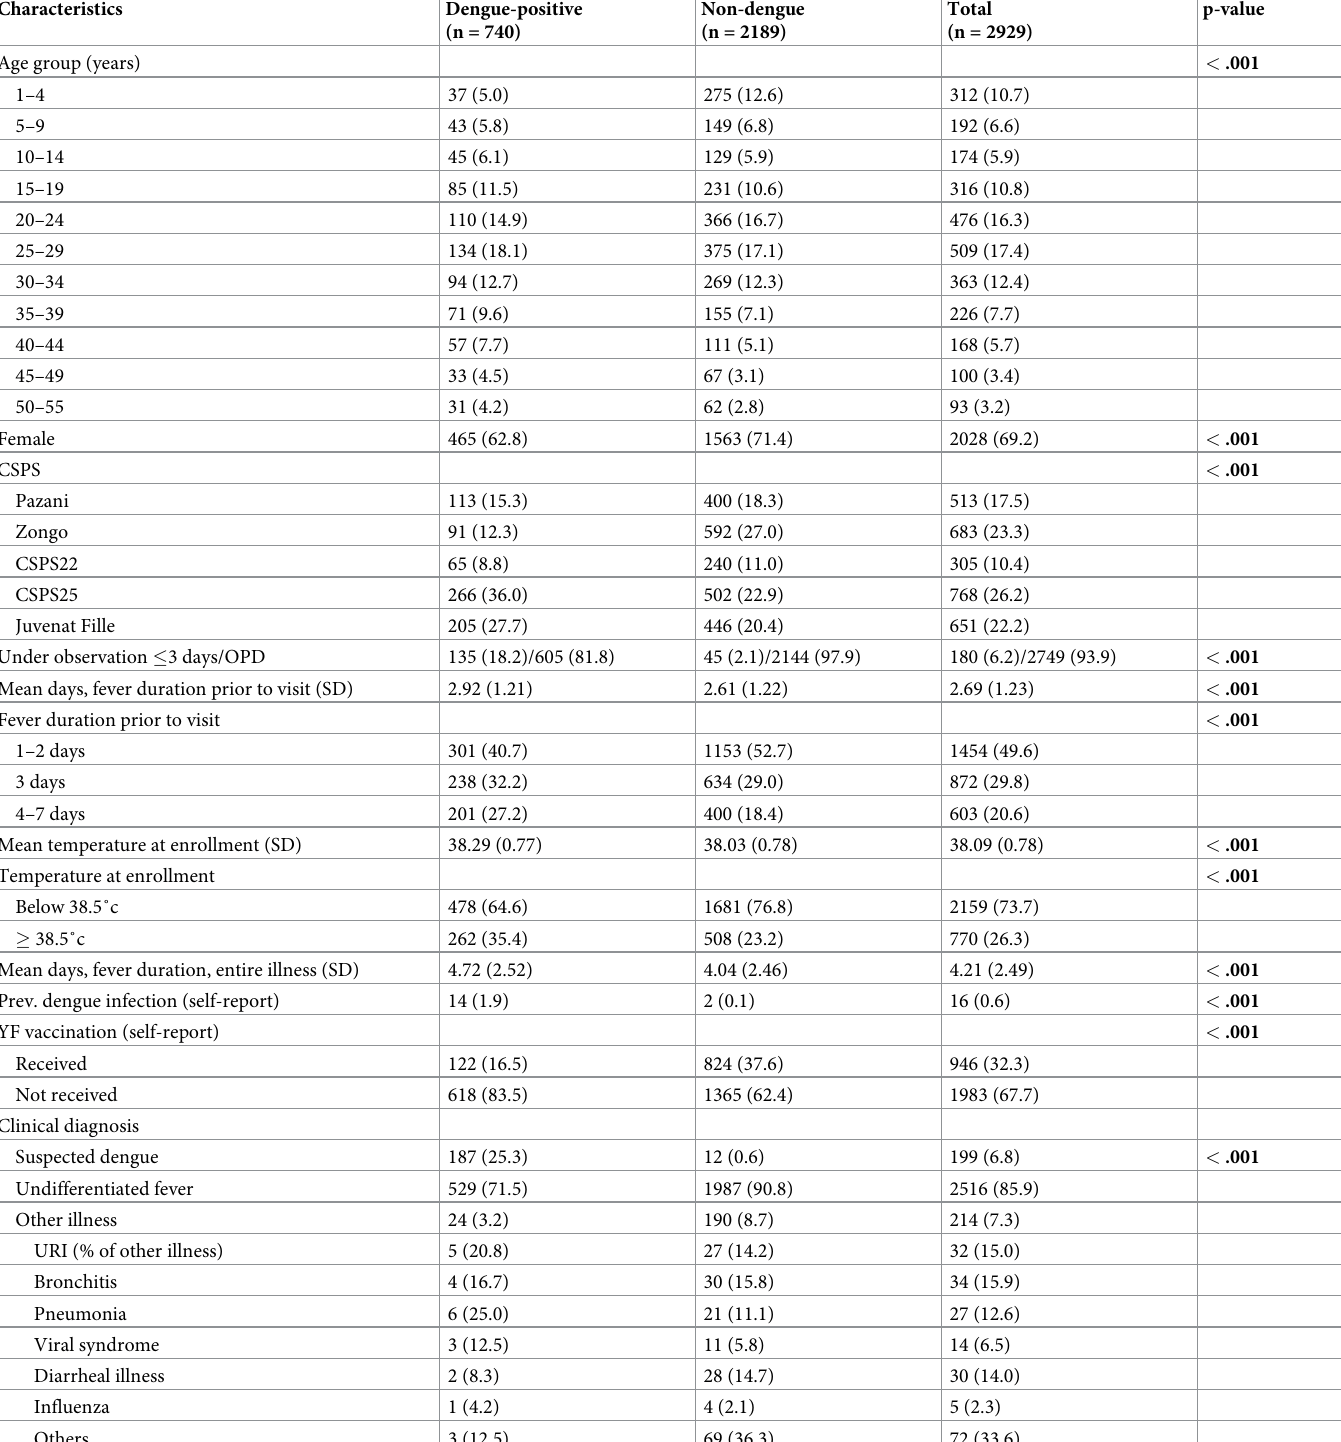
Table 1. Demographic and clinical characteristics of dengue-positive and non-dengue cases in the facility-based fever surveillance established in Ouagadougou, Burkina Faso, between December 2014 and February 2017.